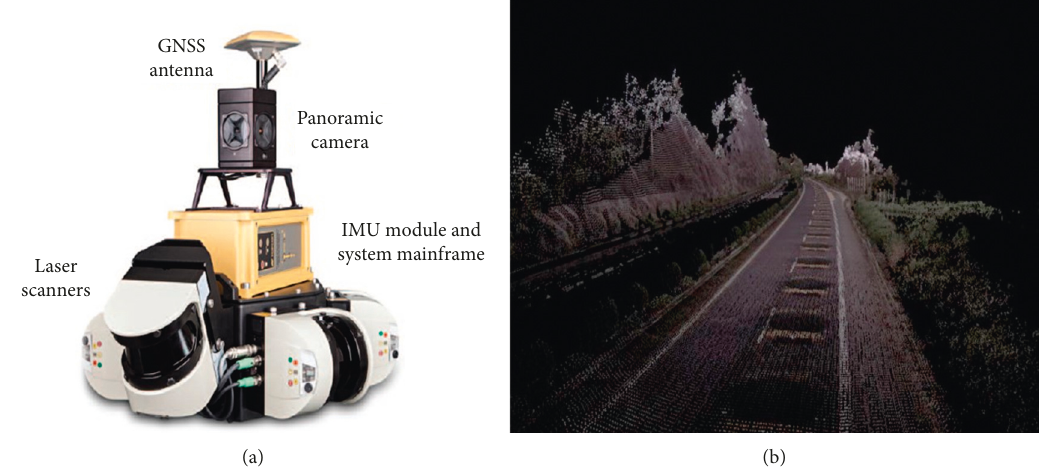
Figure 1: 3D mobile mapping facility and true color point